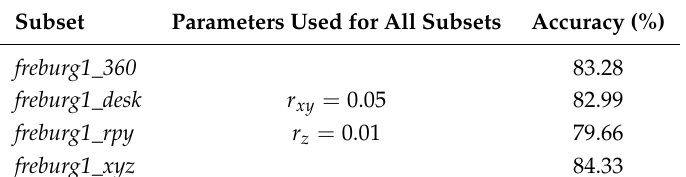
Table 2. Identification on TUM Dataset.